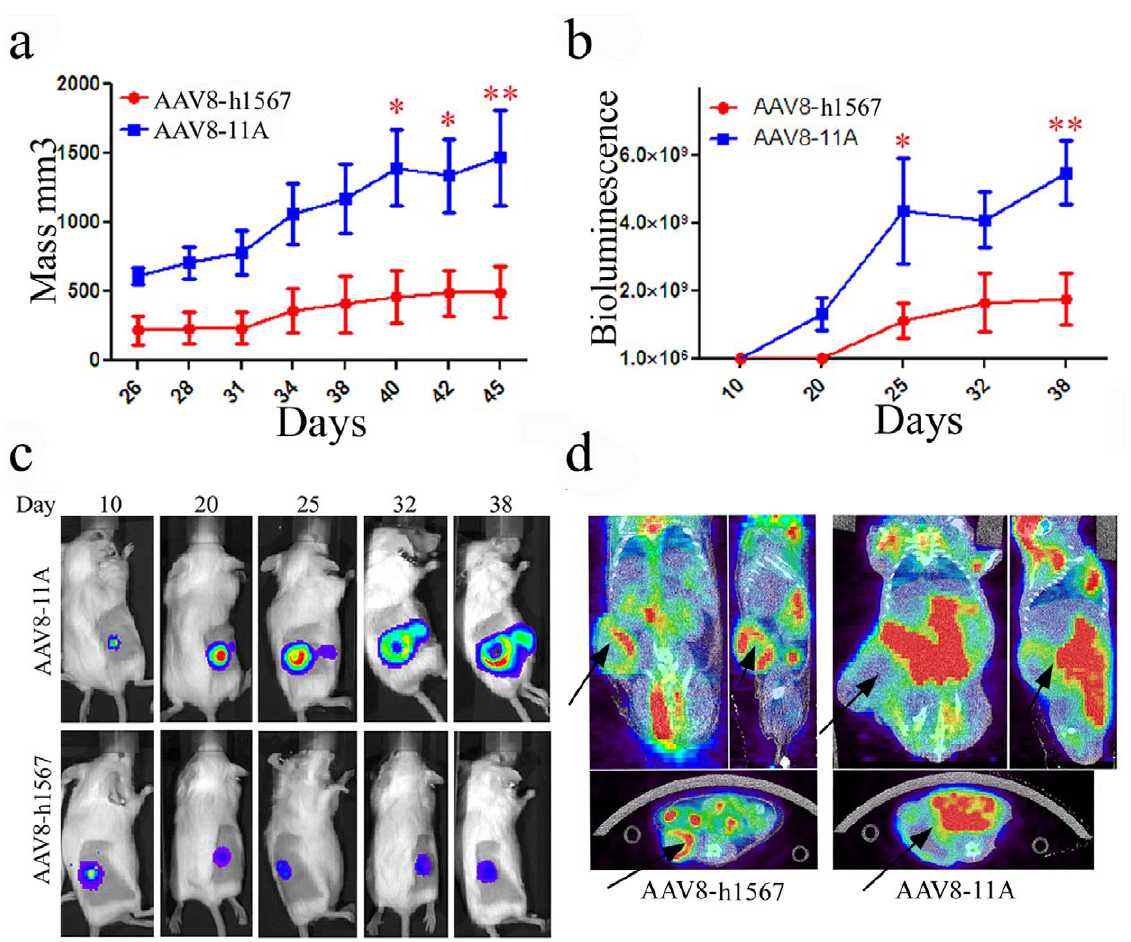
Figure 3. PBMC-mediated antitumor activity of the AAV8-derived h1567 minibody in a xenograft SCID-BEIGE mouse model. ( a ) Growth in tumor volume was quantified by caliper measurements. Tumor progression was significantly inhibited in the AAV8-h1567-treated group compared with the AAV8-11A control group. Mice were given a single intravenous injection of AAV vectors 11 days after inoculation of the tumor cells, which was followed by a single injection of PBMC on day 18. *P , 0.05; **P , 0.01. ( b ) Tumor growth was monitored in vivo by optical imaging and quantified weekly by bioluminescent imaging. *P , 0.05; **P , 0.01. ( c ) Sequential in vivo imaging of tumor growth over time in the tumor mouse model. Panels depict a representative mouse from each group. ( d ) Micro-CT/PET fusion images of representative mice 28 days after tumor inoculation. Representative coronal (left), sagittal (right), and transverse sections (below) are shown for both controls and treated mice. Arrows indicate tumor location. FDG PET revealed a decrease in glucose metabolism in AAV8-h1567-treated mice. Data shown are mean values 6 SD.